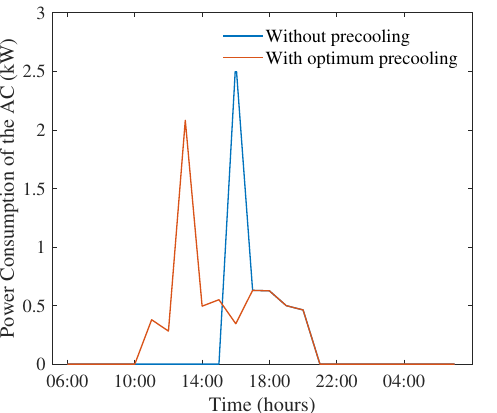
Figure 4. Power consumption of the AC with and without optimum pre-cooling on 8 January